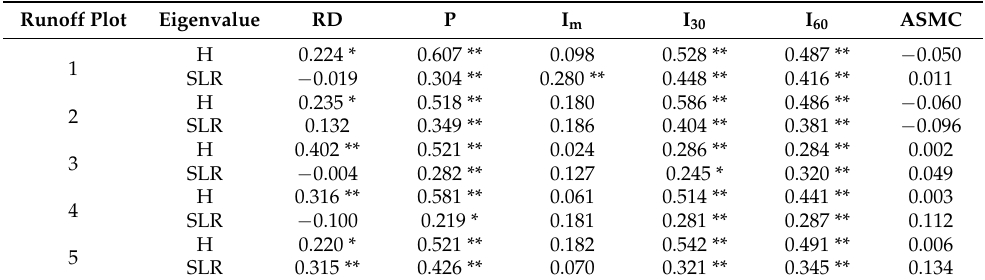
Table 5. Pearson correlation coefficients between runoff, soil loss rate, and their influencing factors for the five runoff plots.